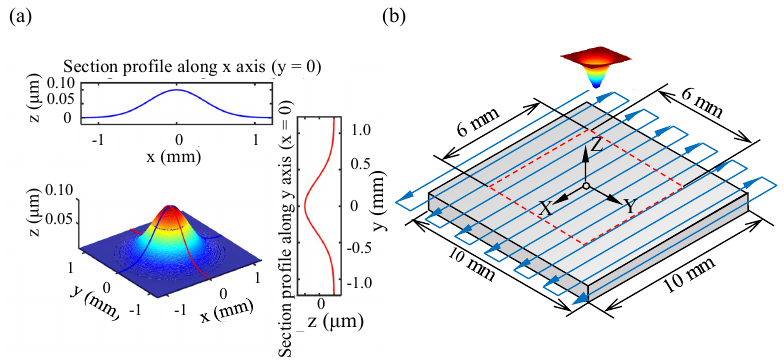
Figure 1. ( a ) Tool influence function (TIF) with Gaussian shape; ( b ) tool path design.